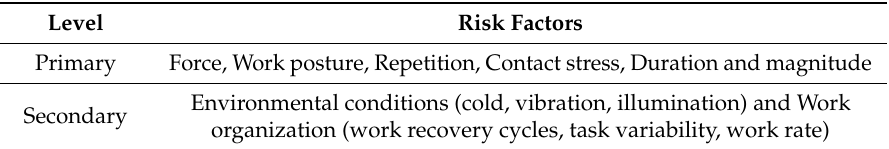
Table 2. Levels of intervention and risk factors [14]. Risk Factors